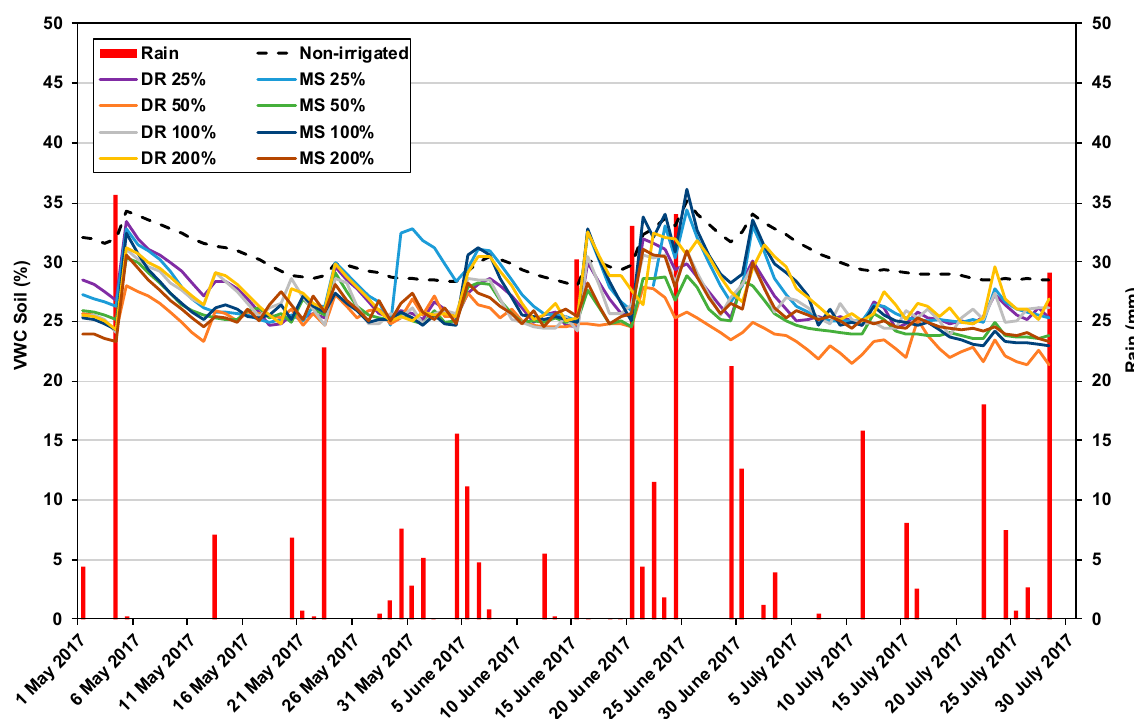
Figure 2. Soil volumetric water content (VWC) for the non-irrigated treatments and for the different combinations of drip (DR) and micro-sprinkler (MS) irrigation with different fertilizer levels (25, 50, 100, and 200%) in 2017. Rain events are shown as vertical bars. The automated irrigation network was activated in 12 May 2017, with the intent of following the thresholds established (from early May to early August: VWC threshold of 25%; from early August to mid-September: VWC threshold of 20%; from mid-September to late September: VWC threshold of 15%; from late September to December: irrigation off). The system was damaged and deactivated after 28 July 2017 because of a lightning strike. For the irrigated treatments, the values are the average of four sensors (two at 20 cm and two at 40 cm depth). For the non-irrigated, values the are averages of 32 sensors (16 at 20 cm and 16 at 40 cm